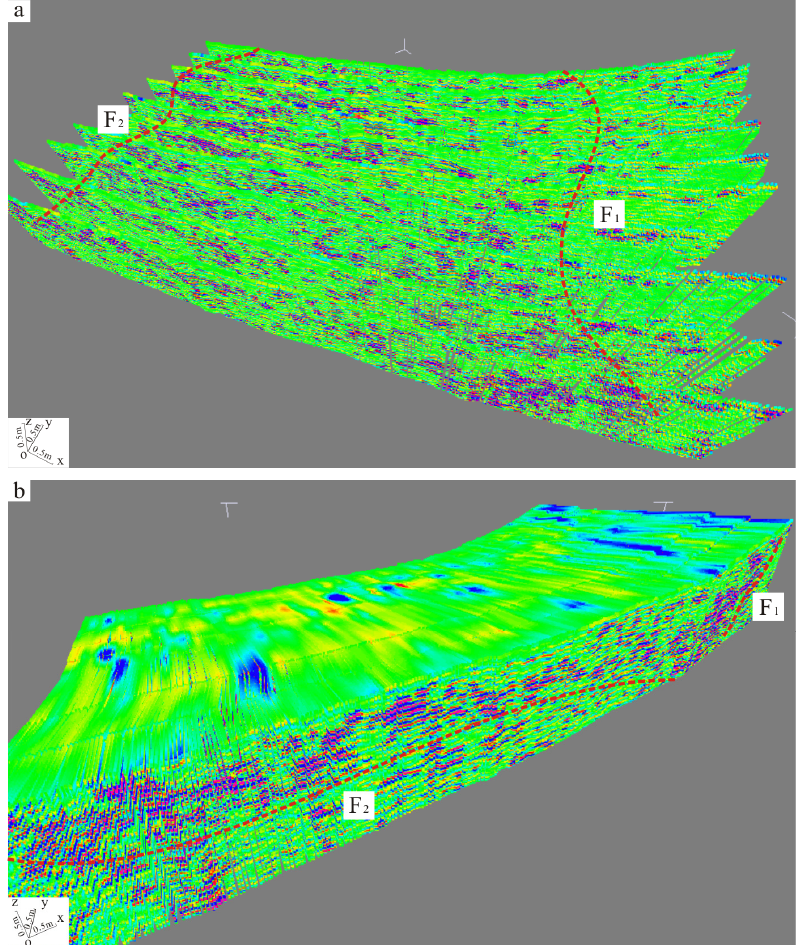
Figure 11. 3D GPR image. ( a ) show the 2D GPR profiles with the same trace interval of 1 m spacing. ( b ) indicates the 3D GPR image of the fault.